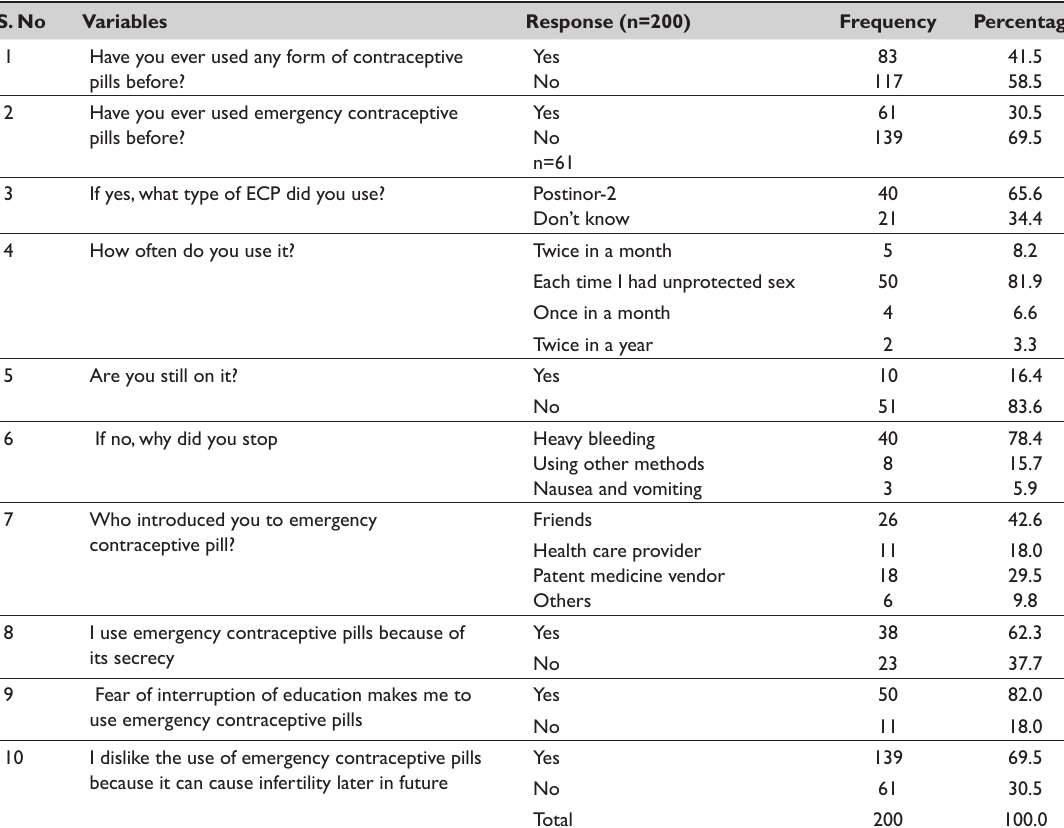
Table 4. Utilization of emergency contraceptive pills (ECP) S. No